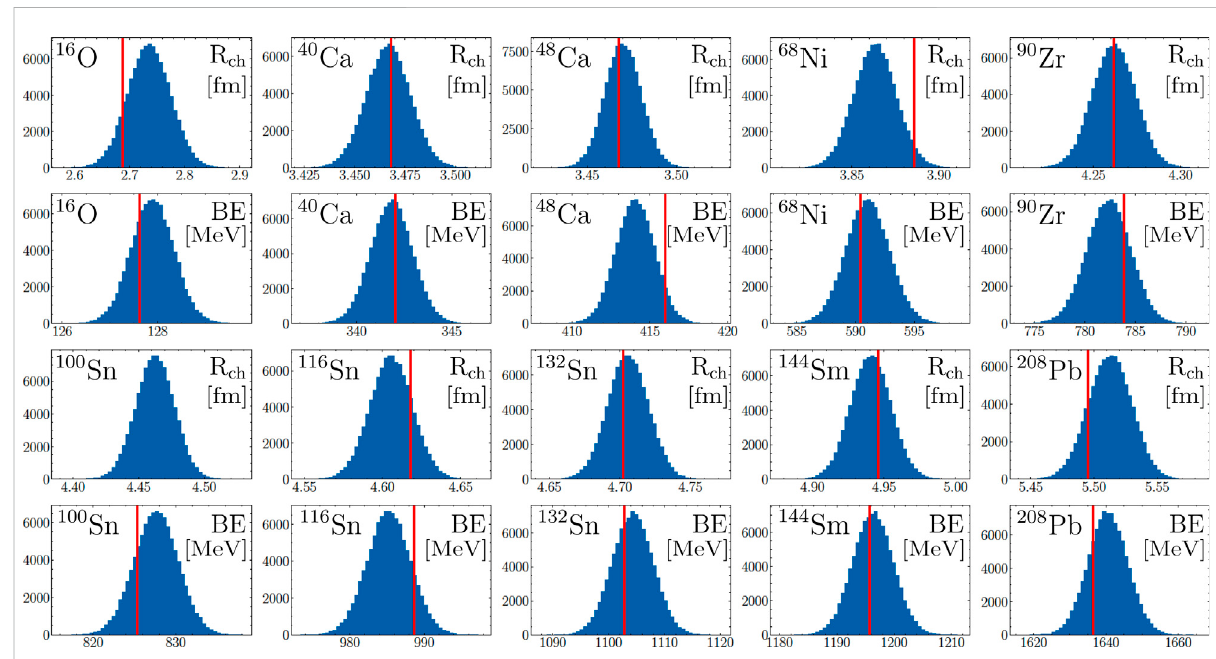
FIGURE 6 Posteriordistributionsforthebindingenergies(inMeV)andchargeradii(infm)ofthetennucleiinvolvedinourstudy.Atotalof100,000samples from the 5,000,000 visited parameter values were used to make these distributions. The vertical red line in each plot represents the associated experimental values, all contained within the 95% credible interval of the model, including the charge radii of 68 Ni which was not included in the calibration of the model. On the other hand, 100 Sn does not have a measured charge radius, making its associated posterior distribution a true prediction from our calibration. The numerical values for the mean and credible intervals on all these quantities are displayed in Table 3.